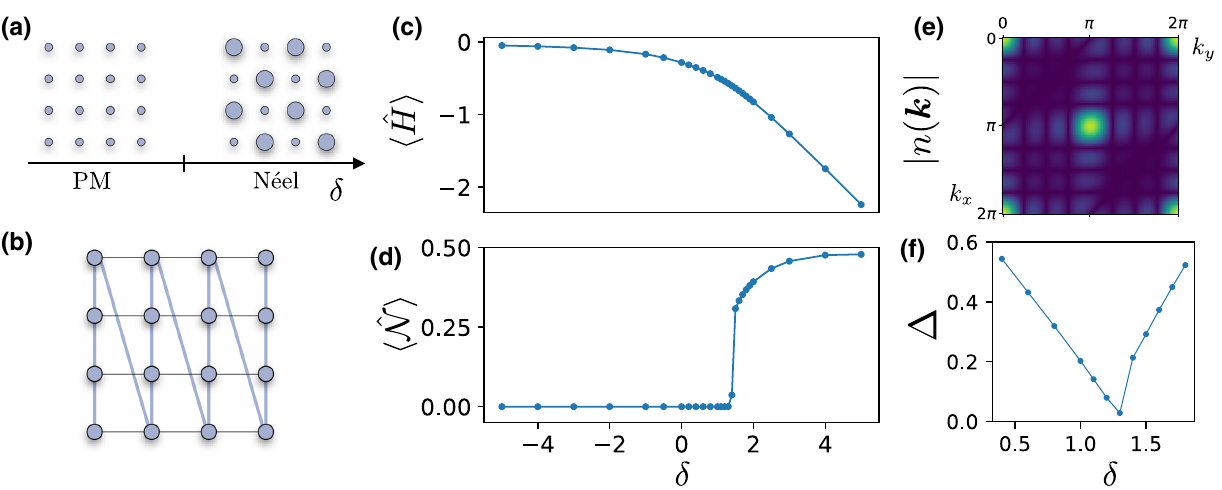
FIG. 1. Rydberg atoms in a two-dimensional square array. (a) The phase diagram at a fixed value of the interaction V = 3 MHz and (cid:2) = 1 MHz. At large and negative detuning, the system is in a disordered phase with all atoms in the ground state. At large and positive detuning, the atoms are found in a checkerboard pattern with Néel order. (b) Snakelike geometry of the MPS path along the square lattice, used for the DMRG simulations. Ground-state energy (c) and the staggered magnetization (Néel order) (d) as a function of the detuning δ for an 8 × 8 array ( V = 3 MHz). (e) Absolute value of the average occupation number in momentum space | n ( k ) | deep into the Z 2 ordered phase ( δ = 4 MHz), showing a peak at k = (π , π) , a signature of antiferromagnetic order. (f) Energy gap (cid:8) between the ground state and the first excited state, detecting a quantum phase transition at detuning δ ≈ 1.3. PM,